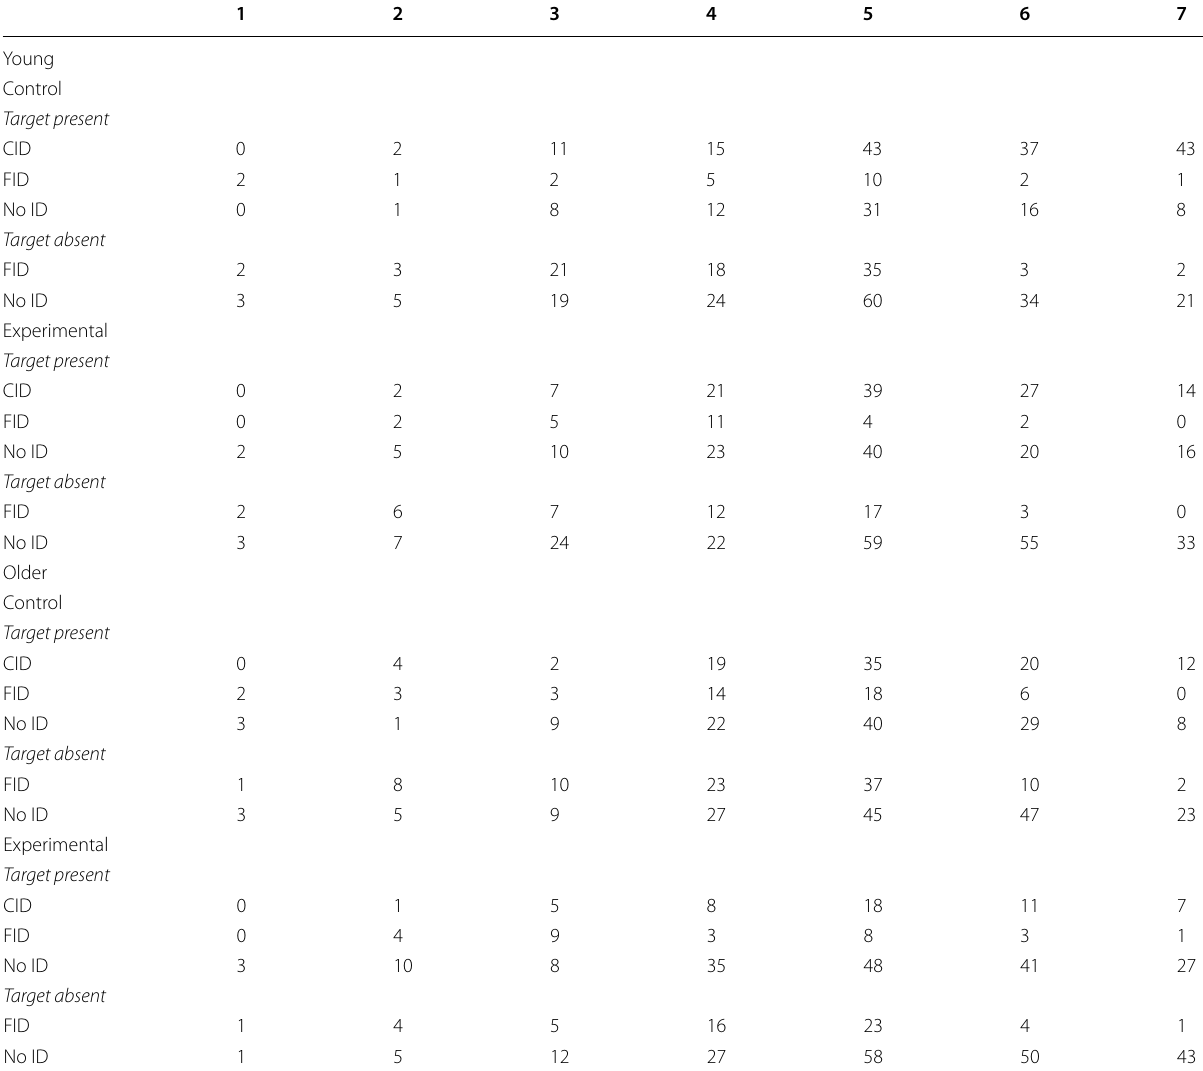
Table 2 Frequencies of correct identifications (CID), filler identifications (FID), and no identifications (No ID) for each age group at each level of confidence for the control and experimental